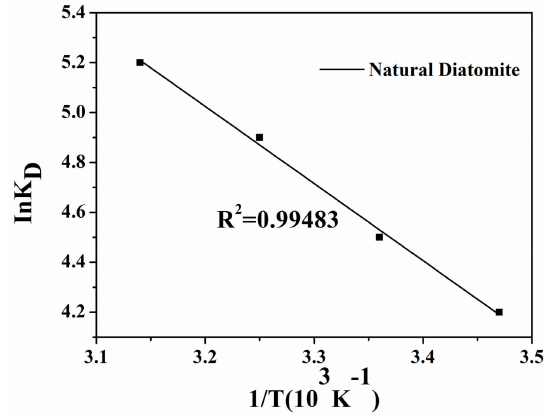
Figure 14. Raw diatomite adsorption of 1-naphthol lnK D versus 1/T (pH 3, 1-naphthol concentration 10 mg/L, diatomite consumption 0.5 g and adsorption time 30 min).